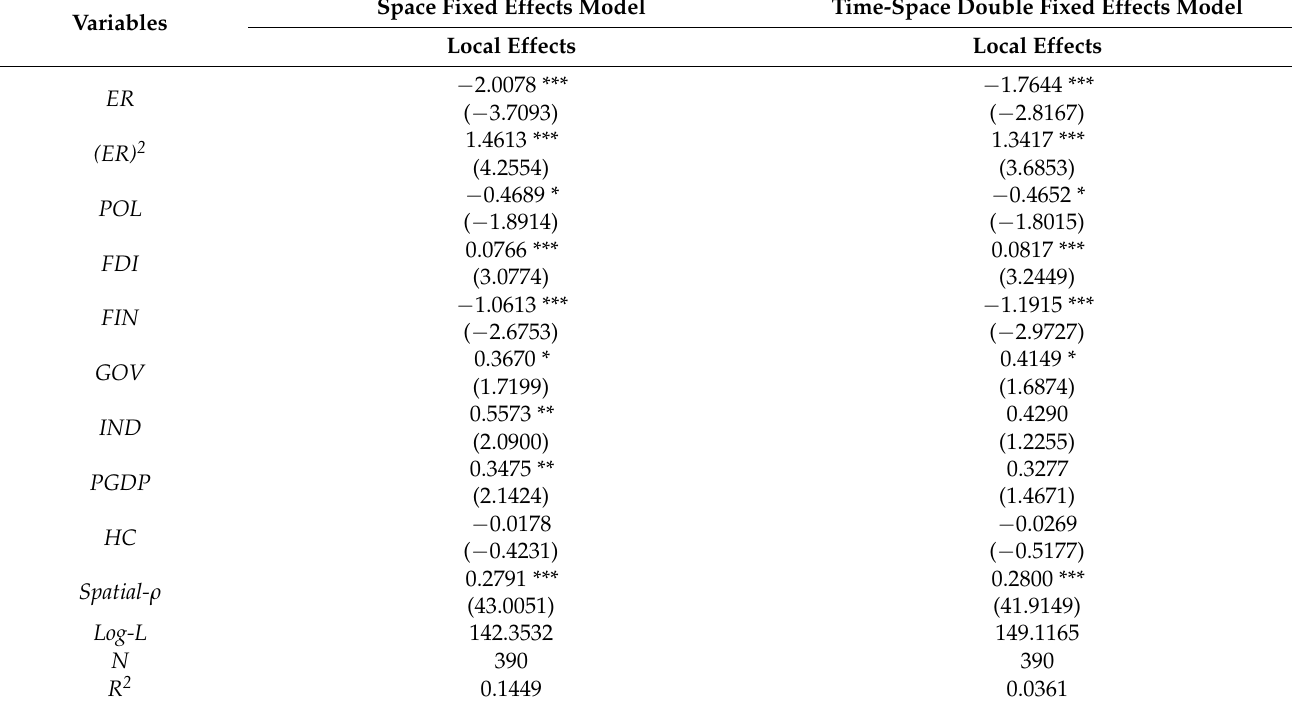
Table 8. The mechanism results of the neighborhood